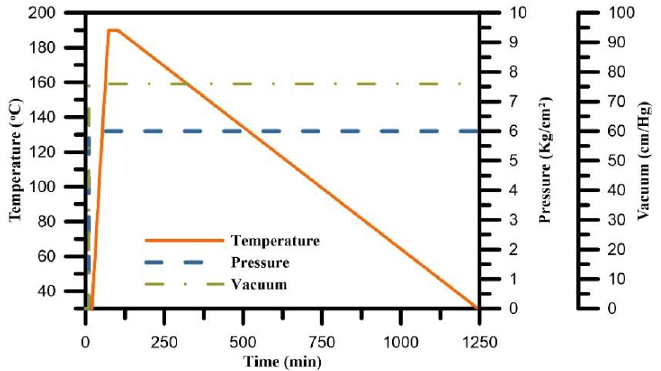
Figure 6. The conditions of the CFRP composite curing process.